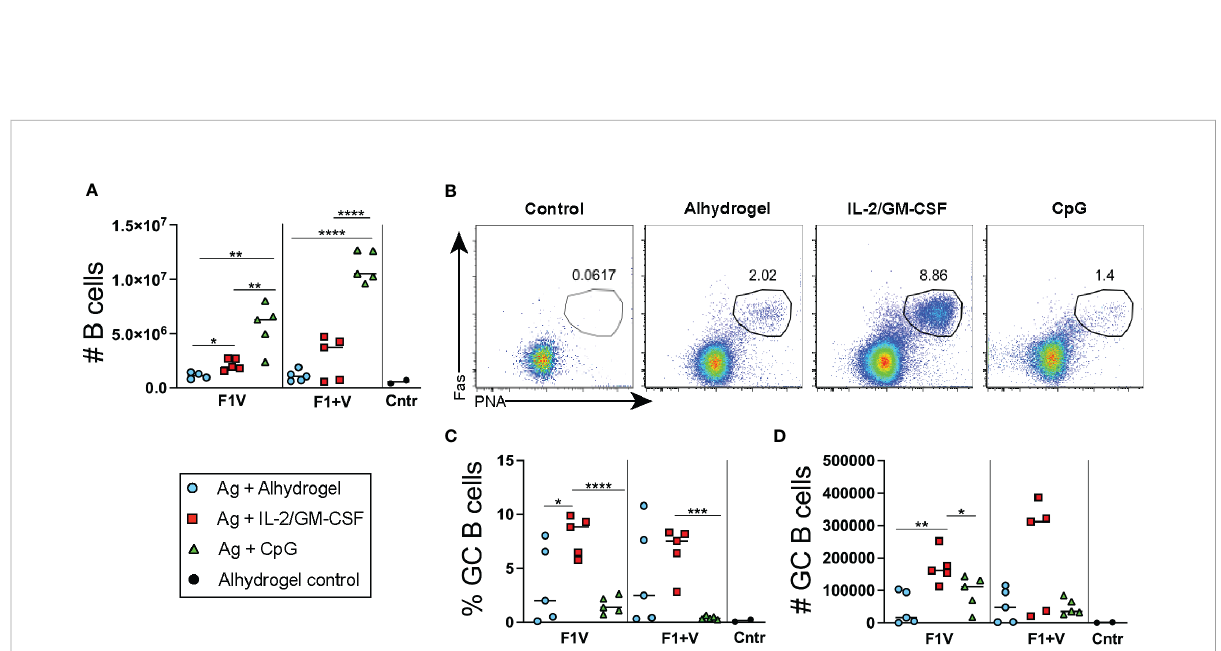
FIGURE 4 Germinal center B cell responses 7 days post-immunization. Analysis of lymphocyte responses in the draining lymph nodes (dLNs) 7 days post- immunization. (A) Total number of CD19+ cells in dLNs. (B) Flow cytometry analysis of CD19+ gated B cells with gate showing PNA+Fas+ GC B cells. (C) Frequency and (D) number of GC B cells. n=5 per group per experiment at each time point. Data shown are from one experiment and are representative of two independent experiments. Statistically signi fi cant p values were determined using a two-tailed unpaired Student t test; *p < 0.05, **p < 0.01, ***p < 0.001, ****p < 0.0001.